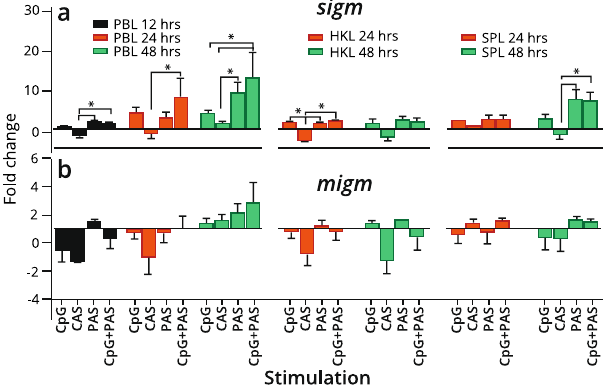
Figure 4. Expression of B cell markers genes in IgM + B cells treated with CpG and/or condition supernatants. IgM + B cells from peripheral blood (PB), head kidney (HK) and spleen leukocytes were MACS sorted and analyzed by RT-qPCR for expression of ( a ) secreted IgM ( sigm ) and ( b ) membrane IgM ( migm ). Gene expression data at each time point were normalized against the reference gene EF1aB and fold changes were calculated using the unstimulated sample at the same time point 74 . Data represent mean ± s.e.m. from at least three individuals (n = 3 to 6). The line intersecting the y-axis at 1 represents the unstimulated control that the fold change of the treatments are in relation to. Significant fold changes (p < 0.05) are indicated by * . CAS; Control adherent cell supernatant, PAS; Pulse adherent cell